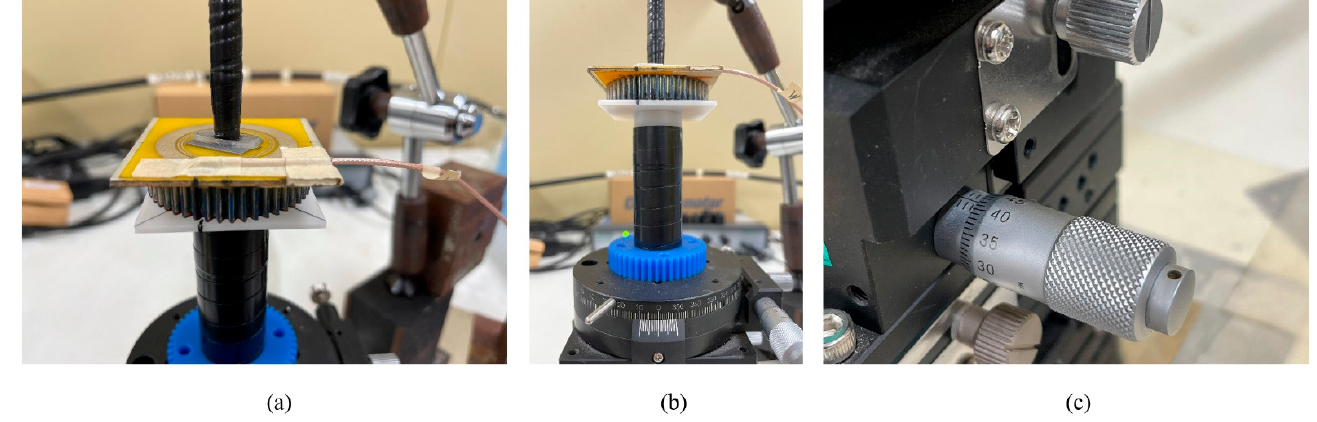
Figure 8. The experimental setting for the phase fluctuation effect at the static condition: ( a ) general setting; ( b ) top rotational plate is locked at 0 degrees of phase angle; ( c ) high precision knob with a ratchet.